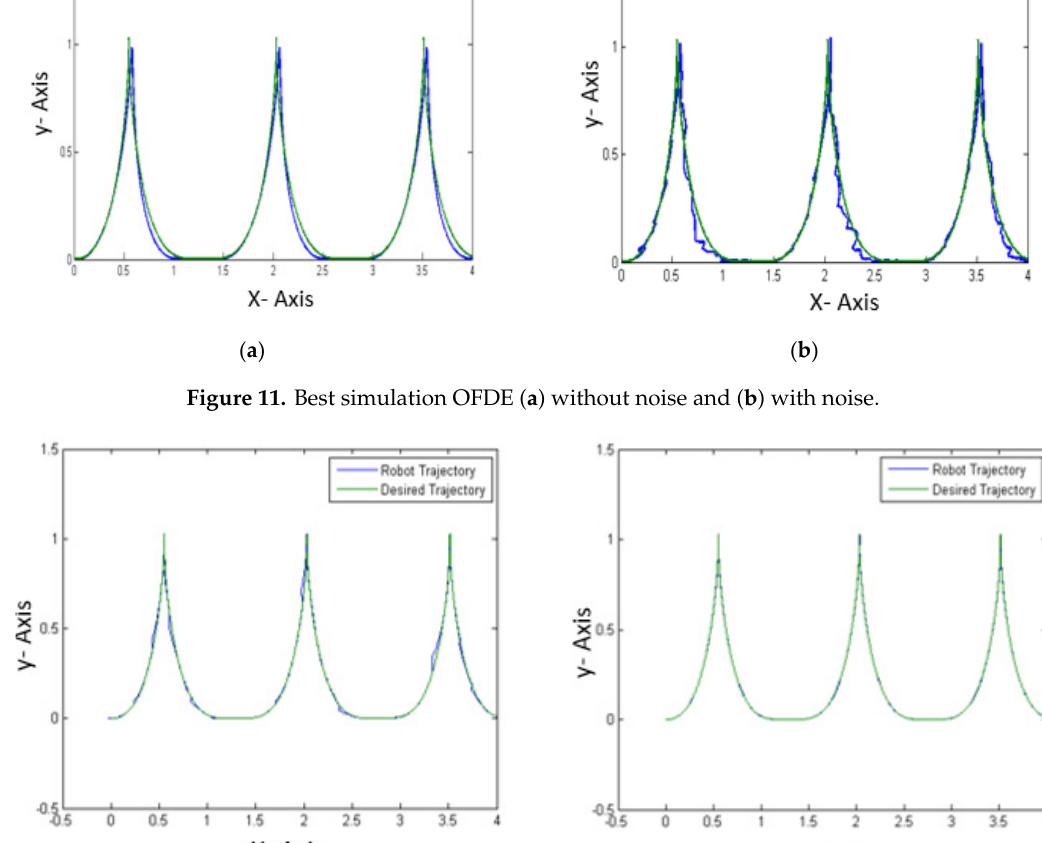
Table 17. Comparison of results with other metaheuristics.